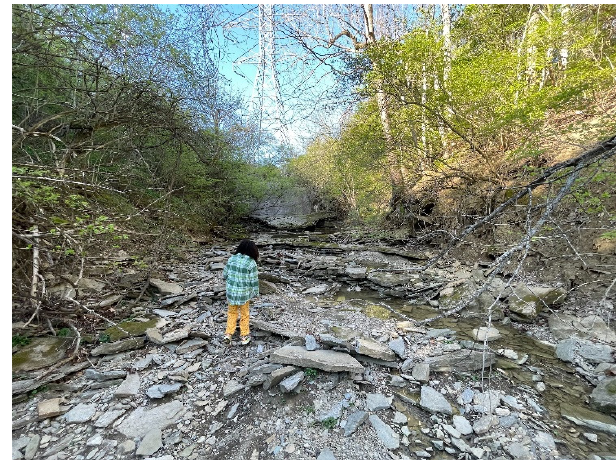
Figure 2. A tower in the background of an otherwise undeveloped area.